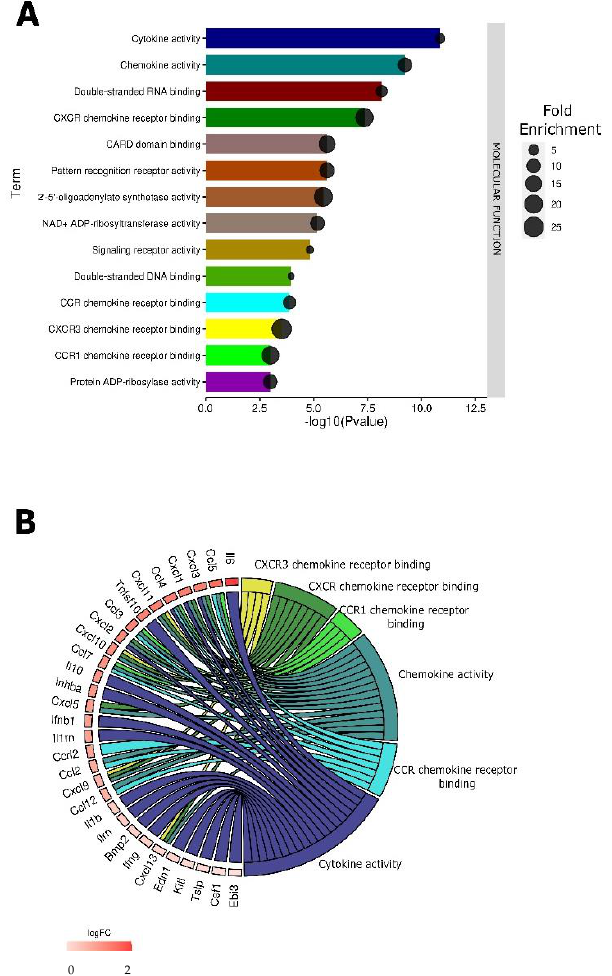
Figure 4. Enriched GO molecular function terms in tumors subjected to pDNA electrotransfer when compared to controls . ( A ) The bar dot plot shows the GO molecular function terms plotted in order of significance. ( B ) The chord plot shows the overlap of the DEGs contributing to chemokine terms arranged in order of their fold change.